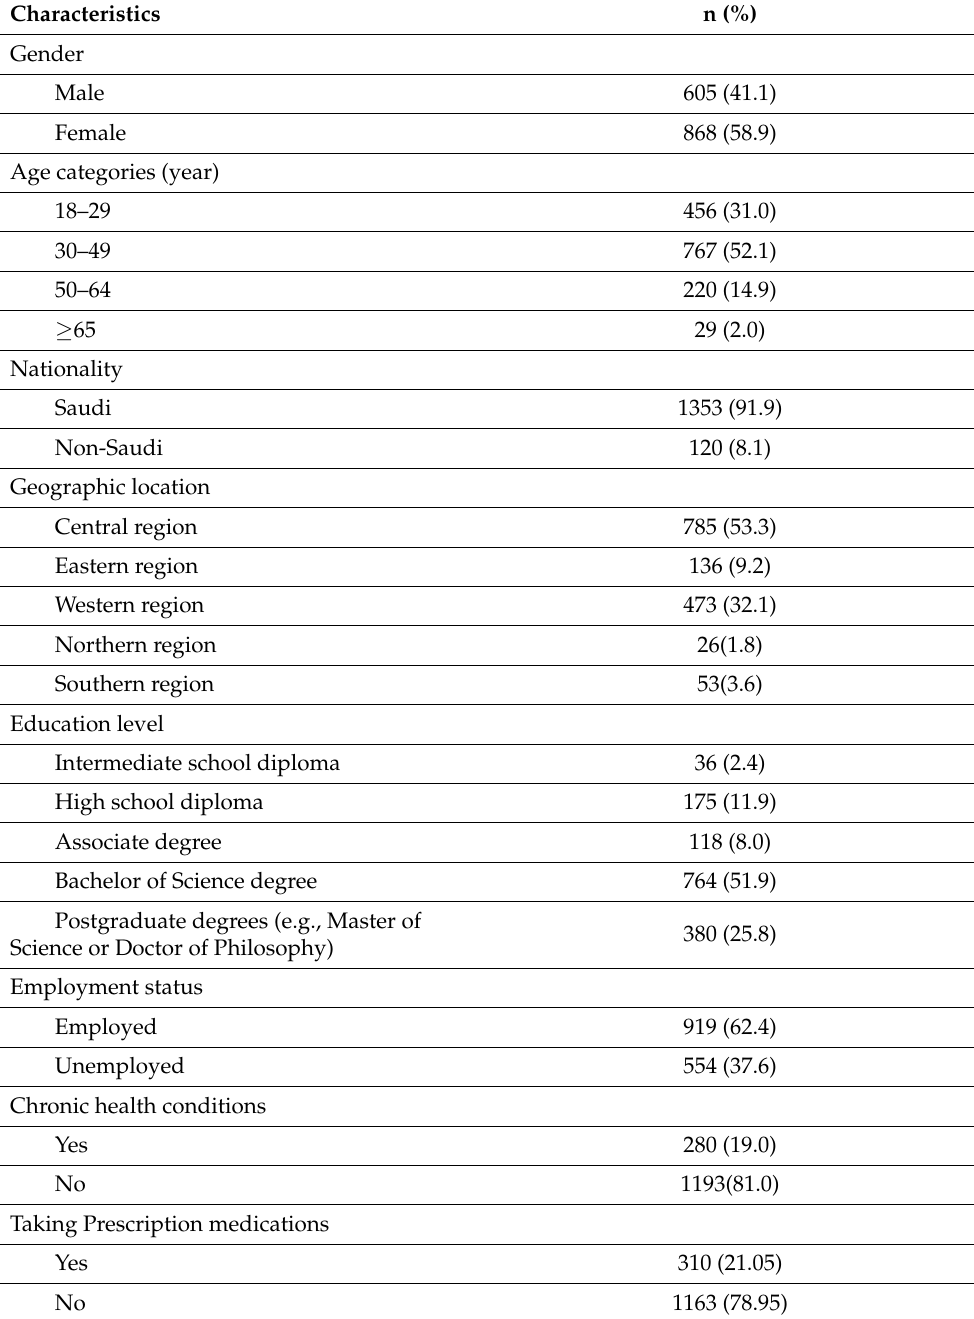
Table 1. Demographic characteristics of the participants (n =